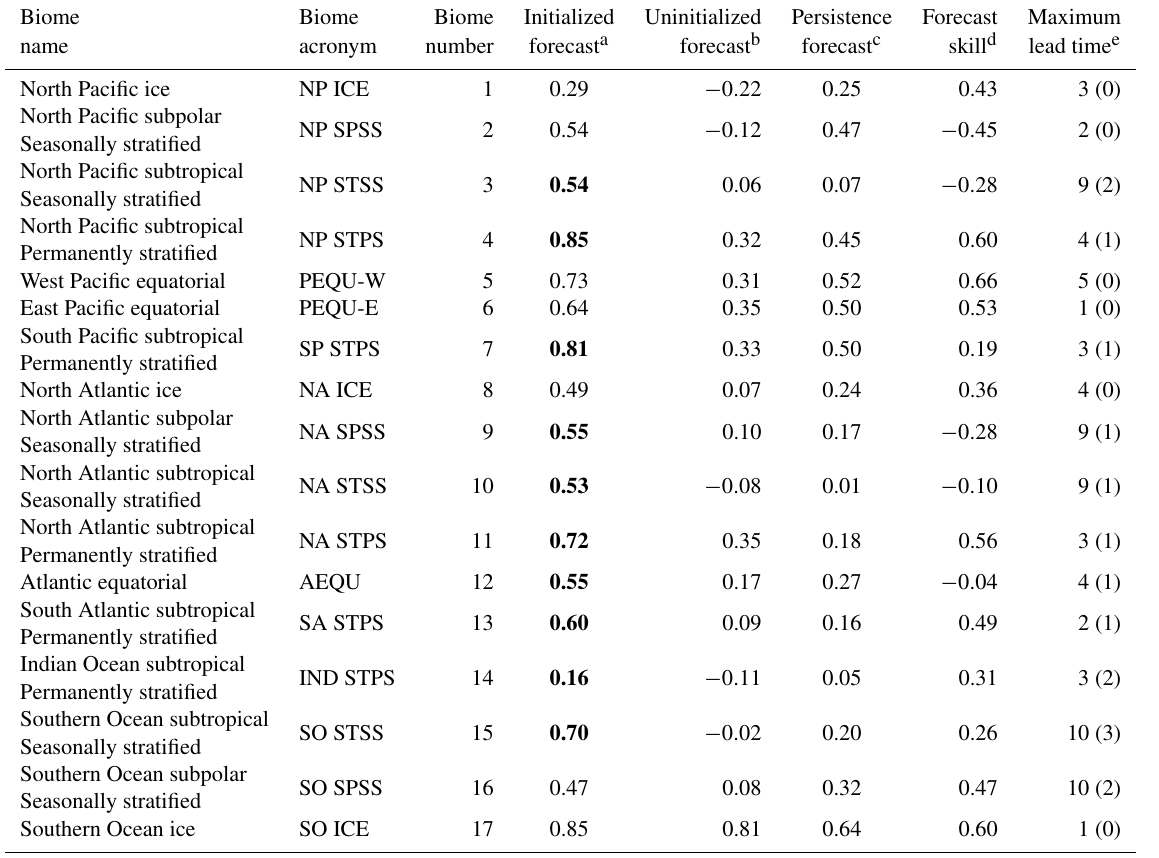
Table 1. Biome-averaged air–sea CO 2 flux statistics.